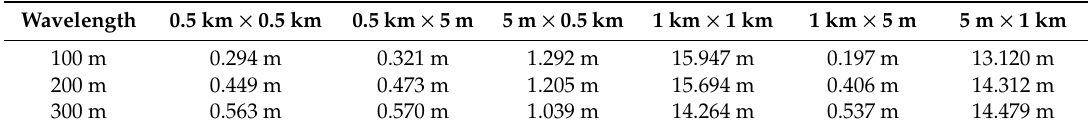
Table 19. The RMS of smoothing layover phase results with di ff erent wavelength (the direction of the smoothing window is in two directions at the same time, in the azimuth and in the